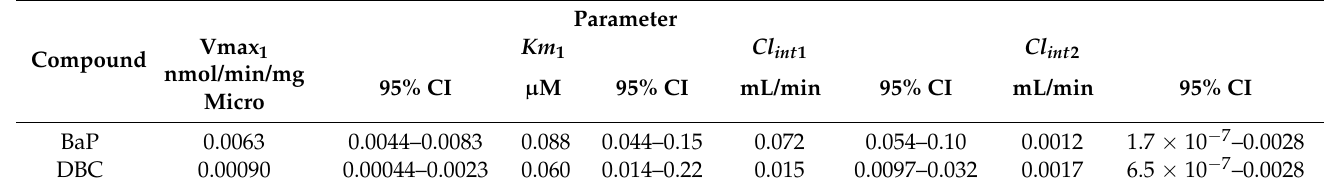
Table 3. Metabolic parameters of benzo[a]pyrene (BaP) and dibenzo[def,p]chrysene (DBC) metabolism in human hepatic microsomes fit to the Michaelis–Menten clearance model, including 95% confi- dence intervals